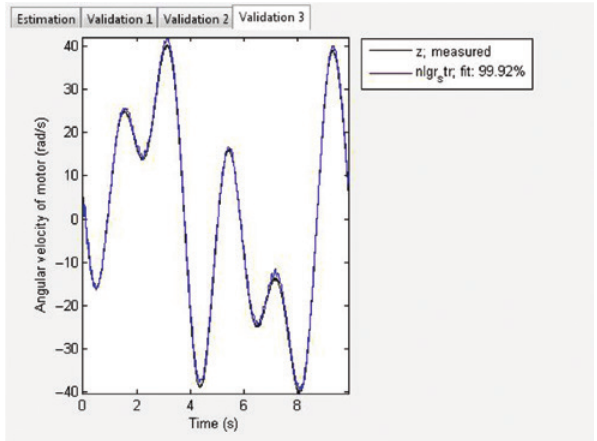
Figure 5: Fitness Value (4) of